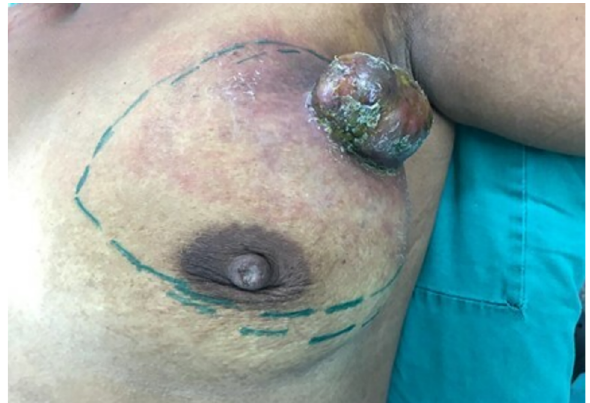
Figure 1. Abscess-like breast cancer before surgery.